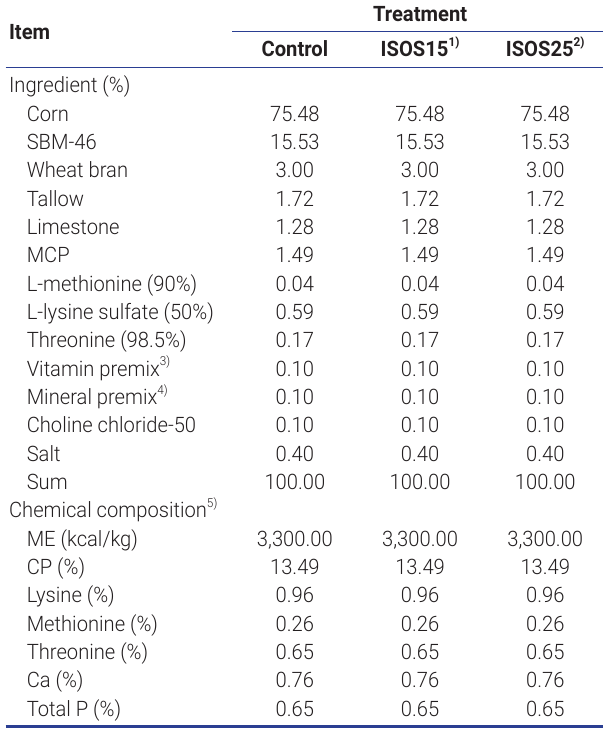
Table 1. The chemical composition of the experimental diet for lac- tating sow